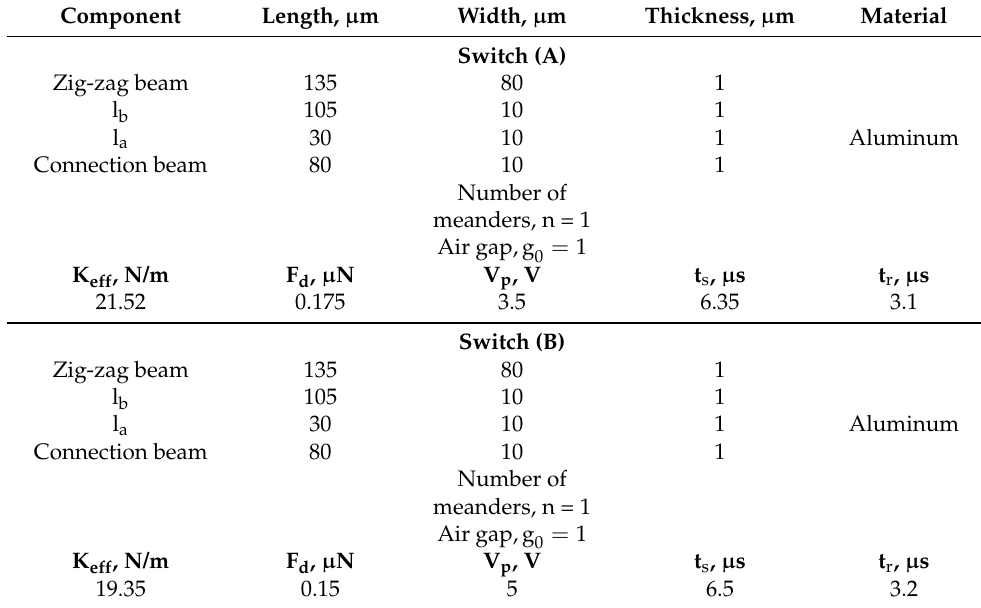
Table 7. Specification of the zig-zag elastic suspensions of switch (A) and switch (B).